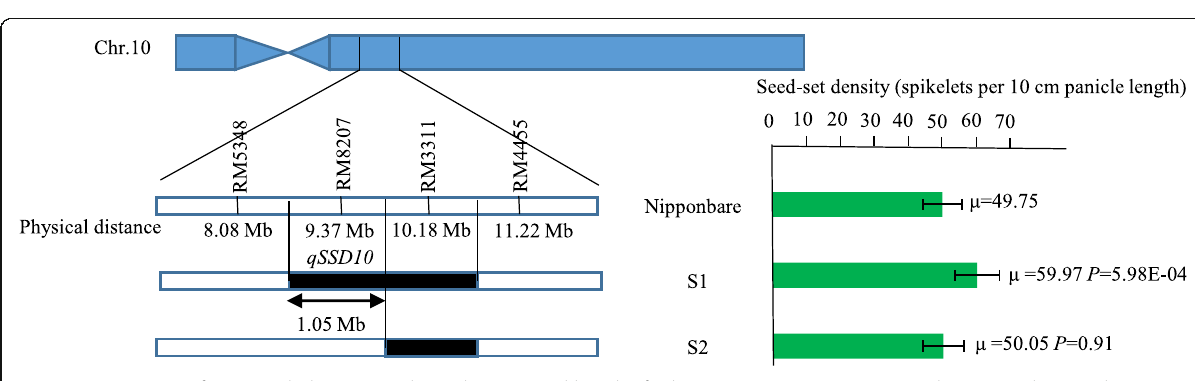
Fig. 8 Fine-mapping of qSSD10 . Black regions indicate the estimated length of substitution segment. S: SSSL. µ is the mean value. P is the probability value from a Student ’ s t-test for the difference in seed-set density between Nipponbare and S1 and